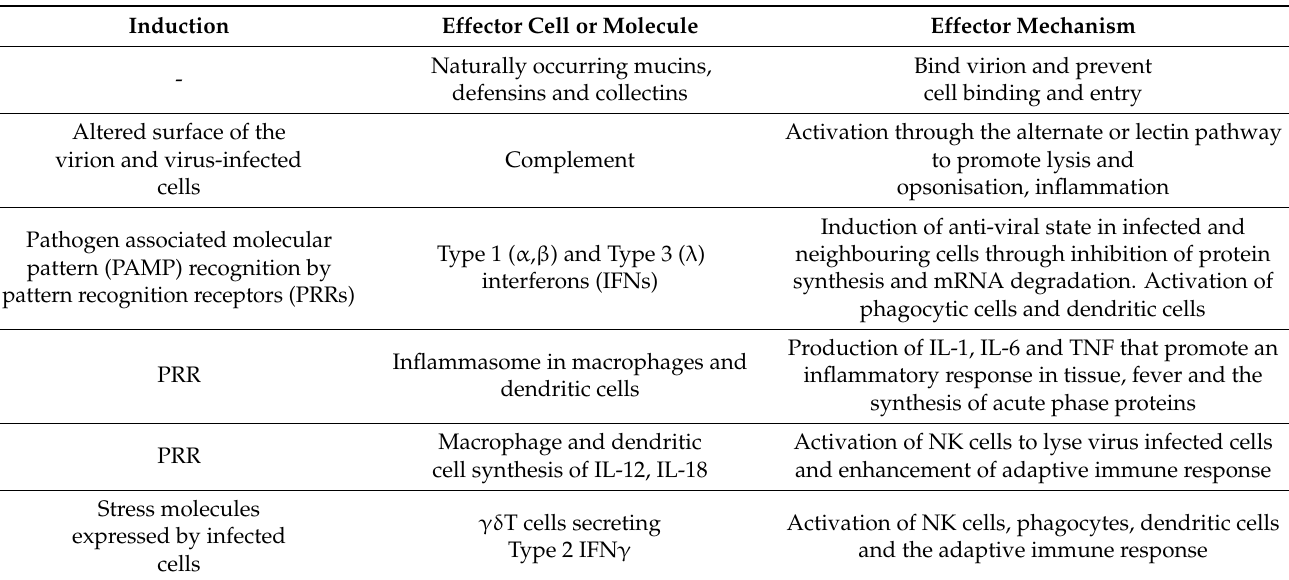
Table 1. Innate immune mechanisms that can protect against SARS-CoV-2 infection in the upper respiratory tract.